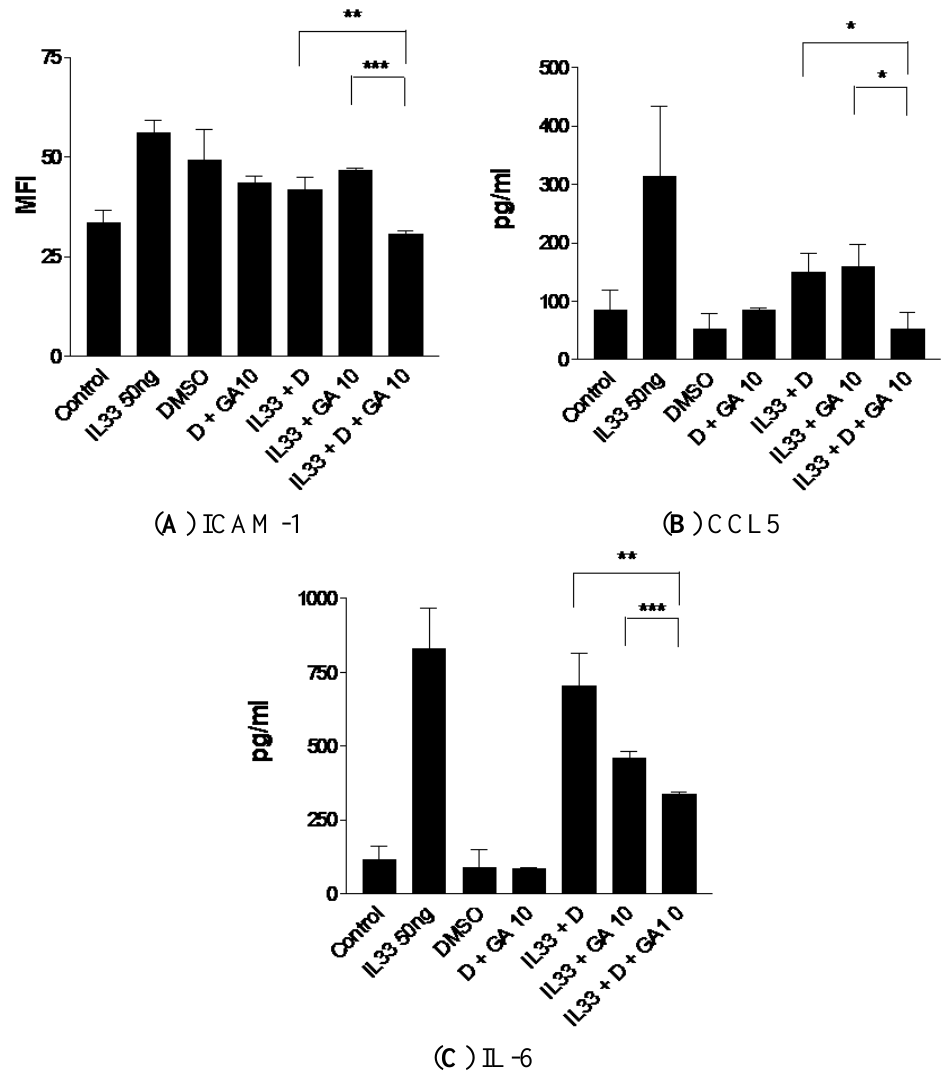
Figure 5. Suppressive effects of ( A ) ICAM-1 expression, ( B ) CCL5 and ( C ) IL-6 release of IL-33-activated human basophilic KU812 cells treated with dexamethasone (0.01 μg/mL) with or without GA (10 μg/mL) together. ( A ) Surface expressions of ICAM-1 on 5,000 KU812 cells are expressed as the mean plus SEM of MFI and normalized by subtracting appropriate isotypic control of three independent experiments. ( B , C ) Release of CCL5 and IL-6 in culture supernatants was determined by CBA. * p < 0.05, ** p < 0.005, *** p < 0.001. D: Dexamethasone 0.01 μg/mL, DMSO: dimethyl sulfoxide 0.2% (vol/vol), GA10: GA 10 μg/mL, GA100: GA 100